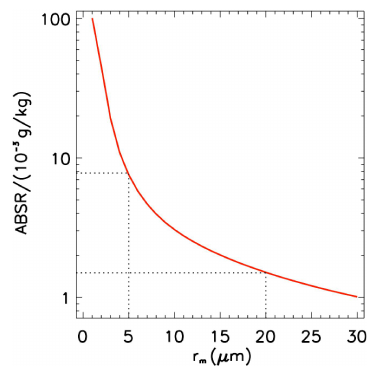
Figure B1. Red curve: Simulated aerosol backscatter ratio ( ABSR ) at 870 nm wavelength per 10 -3 g/kg condensed as ice particles in a lognormal size distribution in dependence of the mode radius ( r m ). The assumed conditions are a lognormal distribution width = 1.4, a refractive index of 1.31 (for ice), and an aspect ratio A = 0.75 for prolate spheroids as proxy for the ice particle asphericity. ABSR for IWC other than 10 -3 g/kg are obtained by appropriate scaling of the ordinate. Black dotted lines: typical range of r m in high thin cirrus clouds (which formed in situ, e.g. by orographically forced upwelling), resulting in an overall uncertainty in BSR of a factor of ~4.